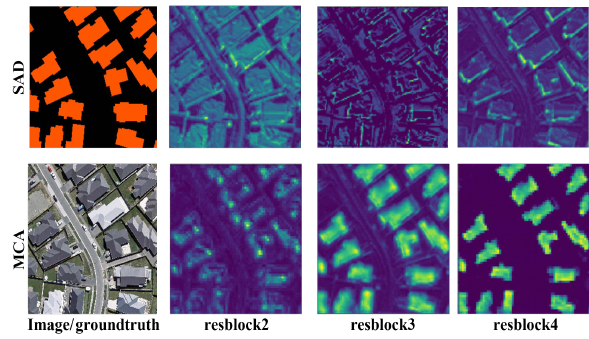
Figure 4. Heatmap in different module applications.